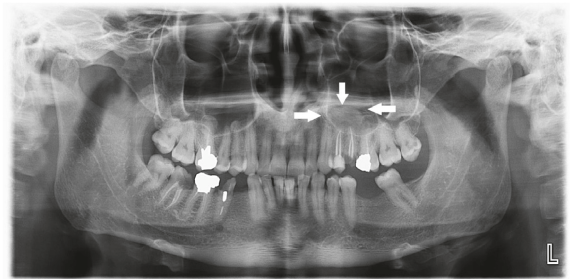
Figure 1: The tips of the arrows show the smooth and well-defined borders of the mucous retention cyst.